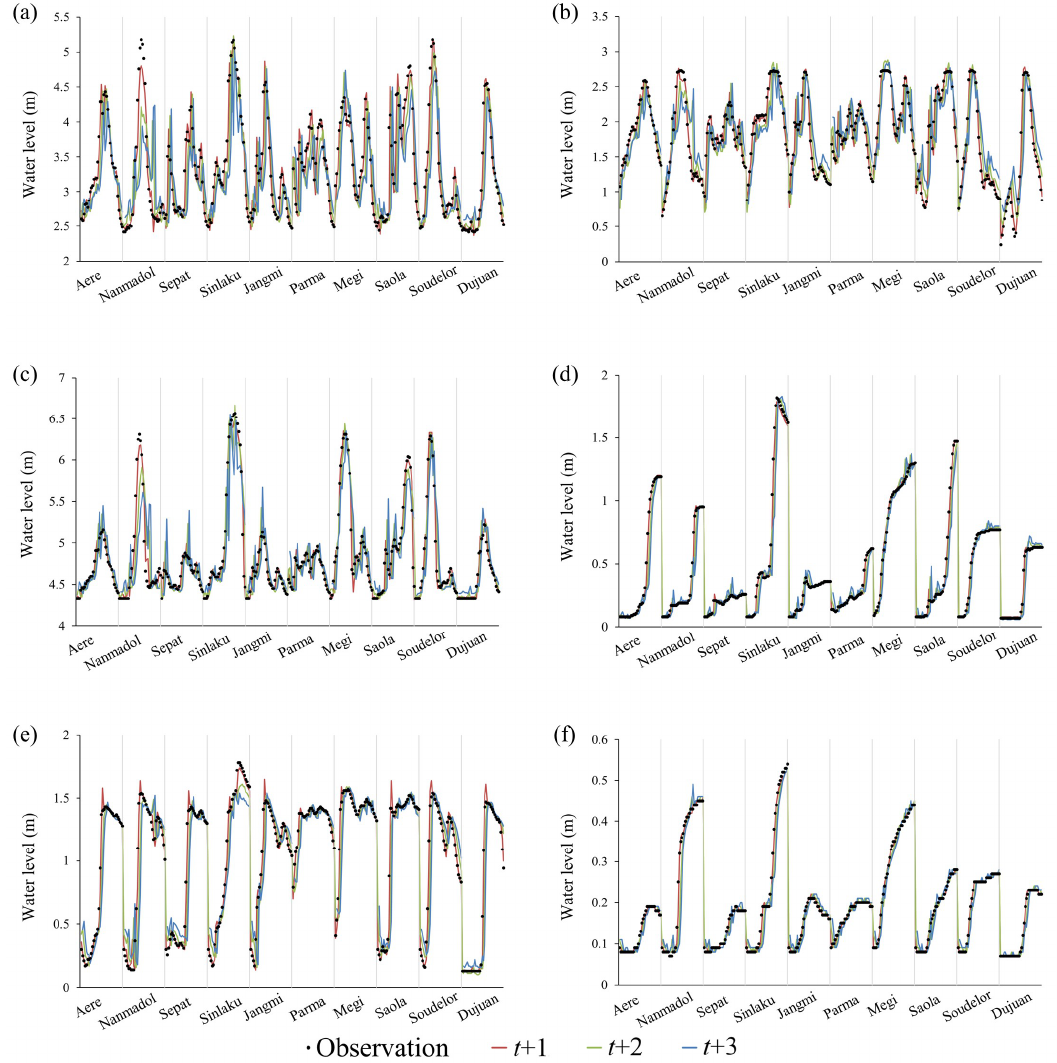
Figure 9. Comparison of observed and forecasted water levels for 1–3 h lead time at ( a ) ISR2, ( b ) KXL1, ( c ) ISR3, ( d ) ISR7, ( e ) GJL1, and ( f ) ISR5.